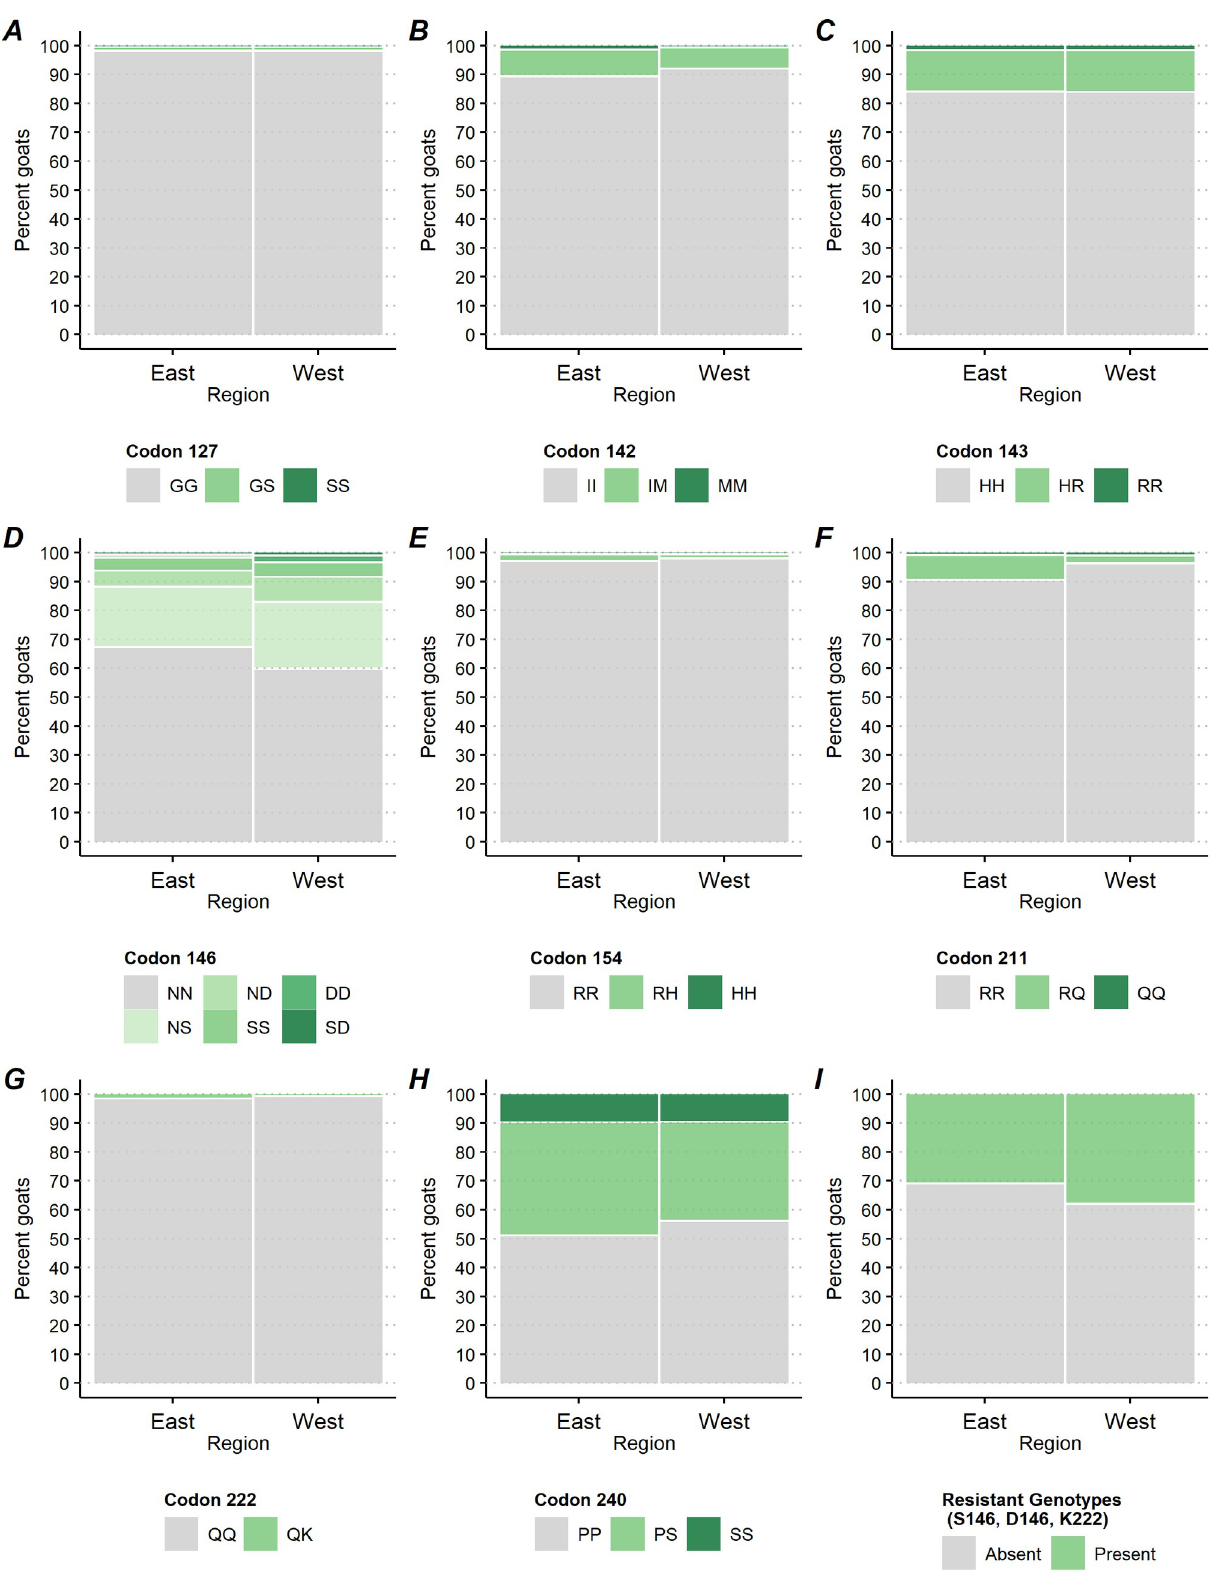
Fig 4. Percentage of goats by caprine PRNP polymorphic variants at codons 127, 142, 143, 146, 154, 211, 222 and 240 and by region. https://doi.org/10.1371/journal.pone.0254998.g004 PLOS ONE | https://doi.org/10.1371/journal.pone.0254998 July 19,